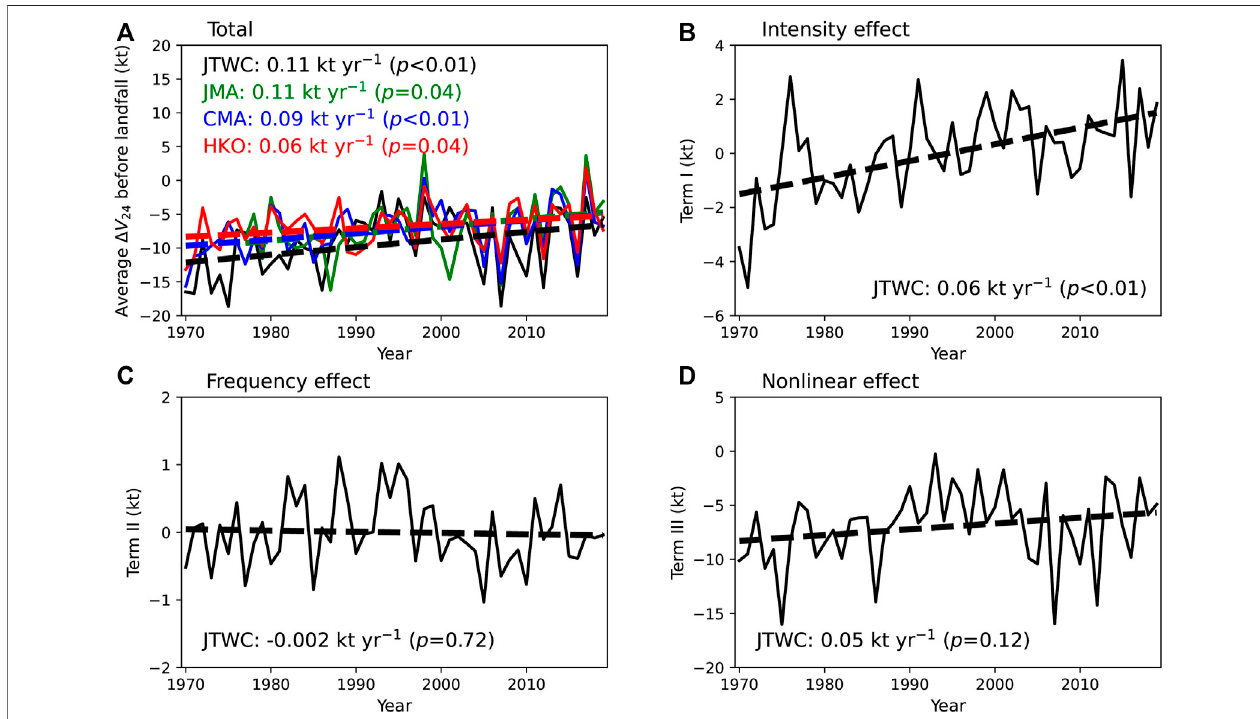
FIGURE 2 | Annual averages of Δ V 24 before landfall during JJASON for the period from 1970 – 2019. Black, green, blue, and red lines in (A) are for JTWC, JMA, CMA,andHKO,respectively.Theoriginalvaluesandtheirthreecomponentsareshownin (A) andin (B – D) ,respectively.Thedashedlinesareobtainedbyleastsquares, while the trends and their respective signi fi cance levels are shown in the panels.